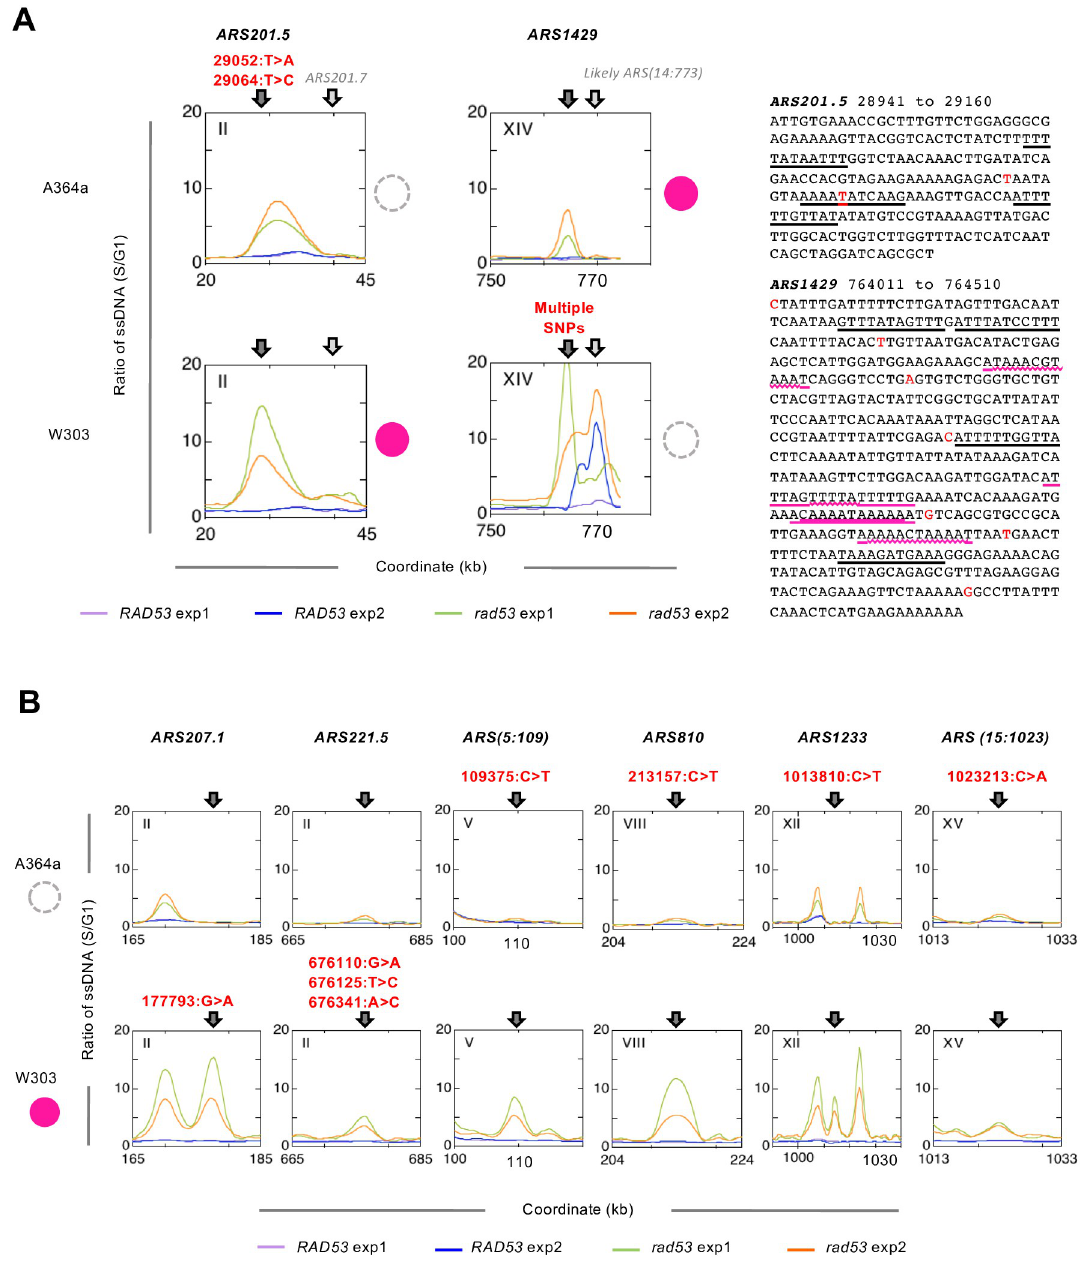
Fig 5. Examples of strain-specific origins with polymorphisms. The corresponding origin status is color coded same as in Fig 4. (A) Two origins with polymorphisms in A364a or W303 background resulting in a shift of initiation sites from the canonical origins. The SNPs (red font) are indicated in the ARS regions based on OriDB curation on the right. The near-matches of ACS elements are underlined in black or, in the case of overlapping elements, in magenta. The sequences shared by overlapping elements are underlined by wavy magenta lines. (B) Six origins that show binary pattern of activation in A364a but not W303 or vice versa , without shifting initiation sites.